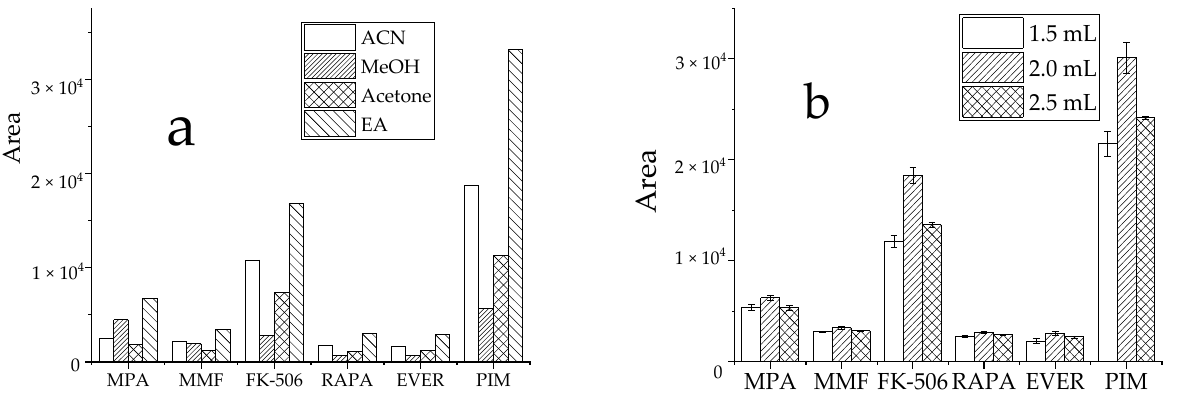
Figure 3. Effect of extractant on the recovery peak area of analyte, ( a ): types of extractant; ( b ): dosage of EA.